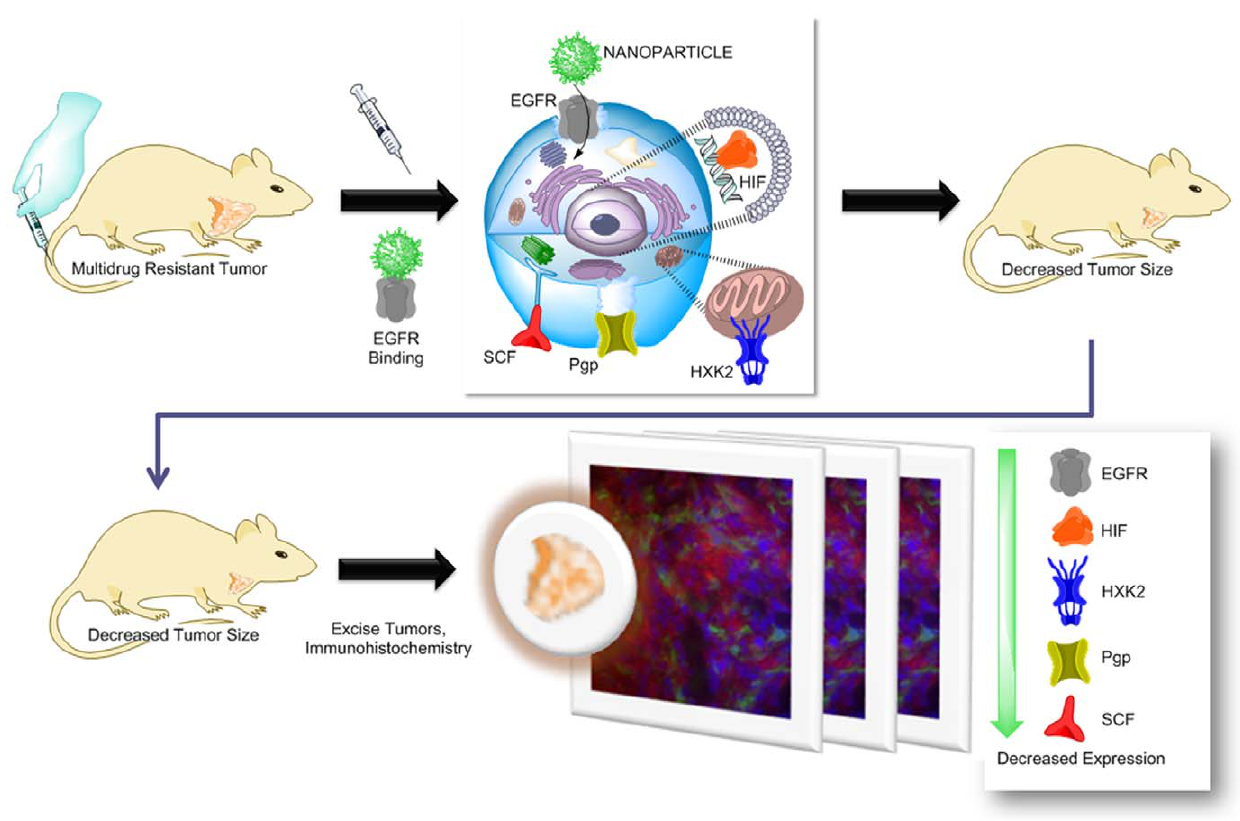
Figure 1. Treatment schema. Nude mice with orthotopic, multidrug resistant breast tumor xenografts were treated with EGFR-targeted, polymer blend nanoparticles loaded with paclitaxel and lonidamine. This nanoparticle formulation is internalized via the EGFR receptor; treatment leads to a cascade of cellular changes and a decrease in tumor volume. As assessed by immunohistochemistry of tumor xenografts, nanoparticle treatment decreased the expression of hypoxic and MDR markers (EGFR, epidermal growth factor receptor; HIF, hypoxia inducible factor; HXK2, hexokinase 2; Pgp, P-glycoprotein; SCF, stem cell factor).